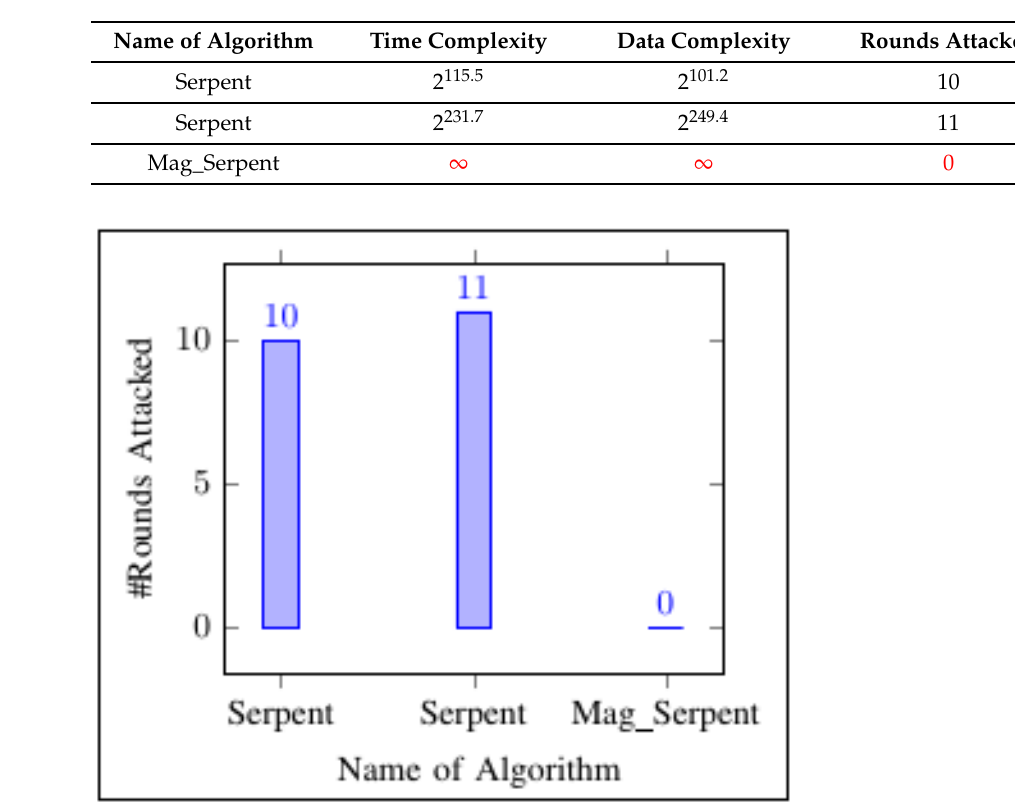
Figure 8. Results of DL attack.